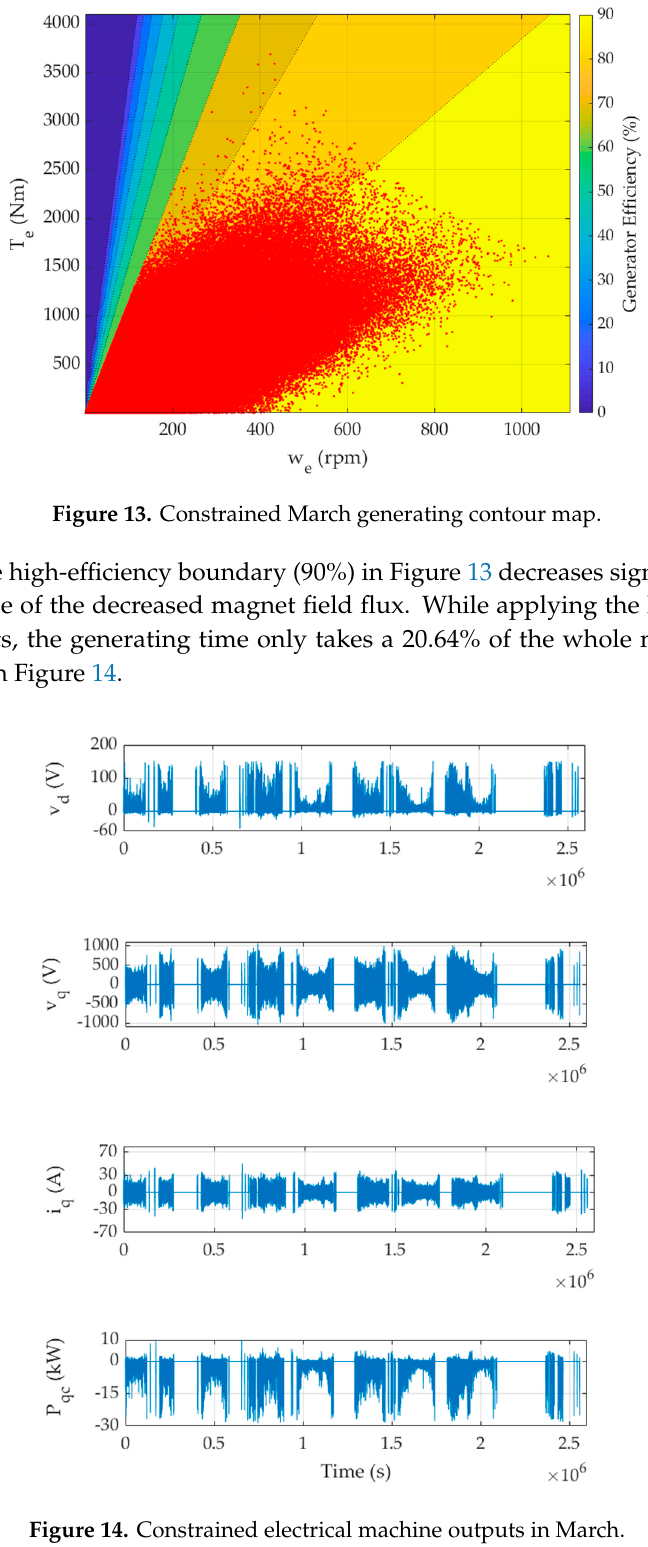
Figure 14. Constrained electrical machine outputs in March.